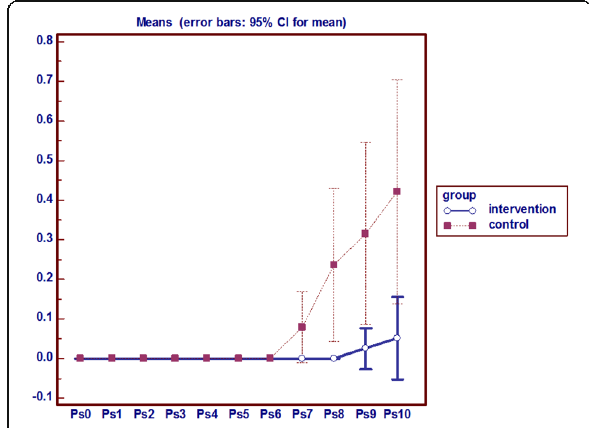
Fig. 4 analysis of variance with repeated measures on the temperature of Sacrum